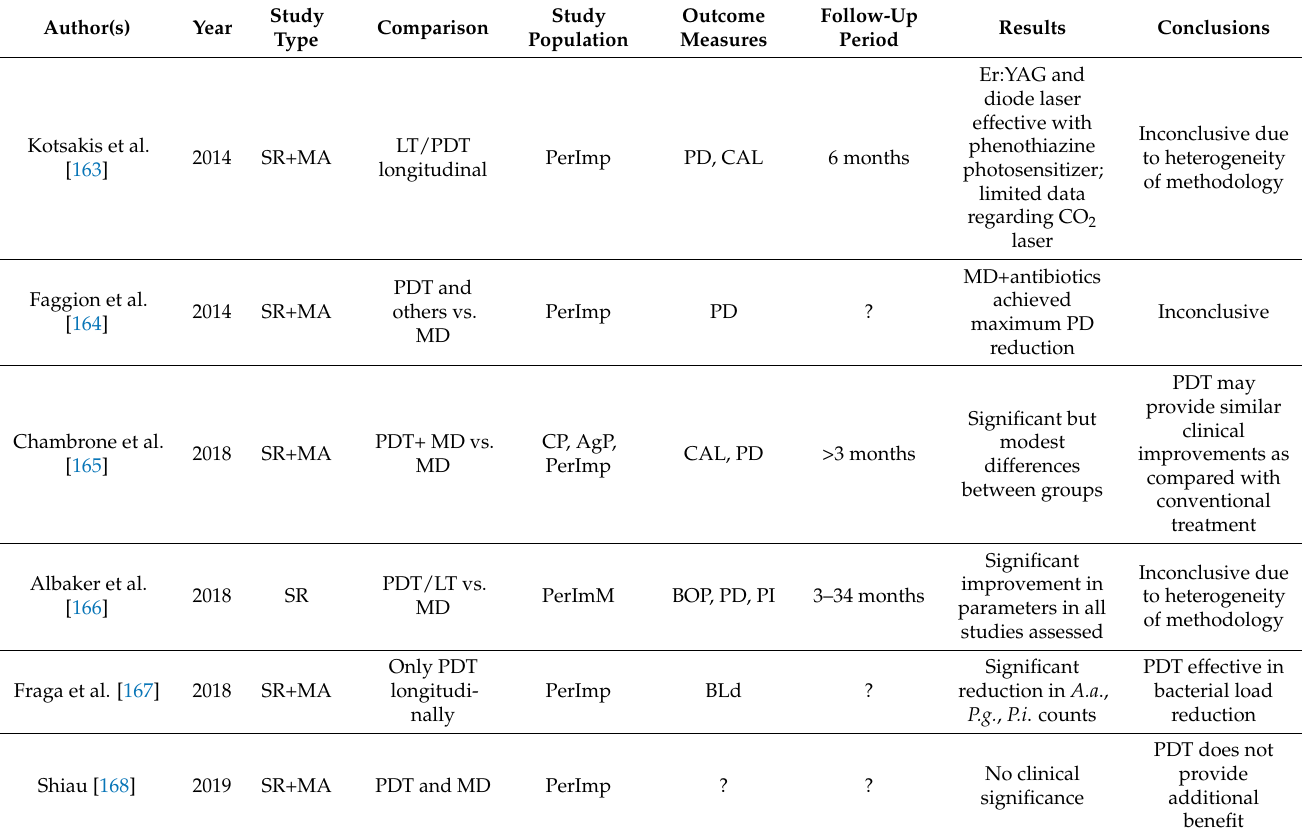
Table 2. Summary of systematic reviews and meta-analyses of PDT as an adjunctive therapy in peri-implant